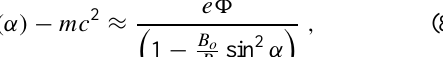
(cid:0) (cid:14) (cid:1) =∞ B B o . The dashed lines between then (cid:0) (cid:14) (cid:1) = B B o 2 and 5. (The dotted